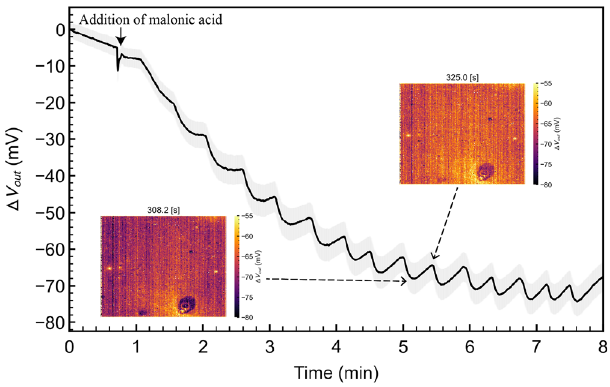
Figure 4. pH oscillation behavior on arrayed-gate ISFET sensor. Δ V out was output for pH analysis. The grey band around the line graph shows the standard errors for the 256 × 256 ISFETs except for 0.5% electrical